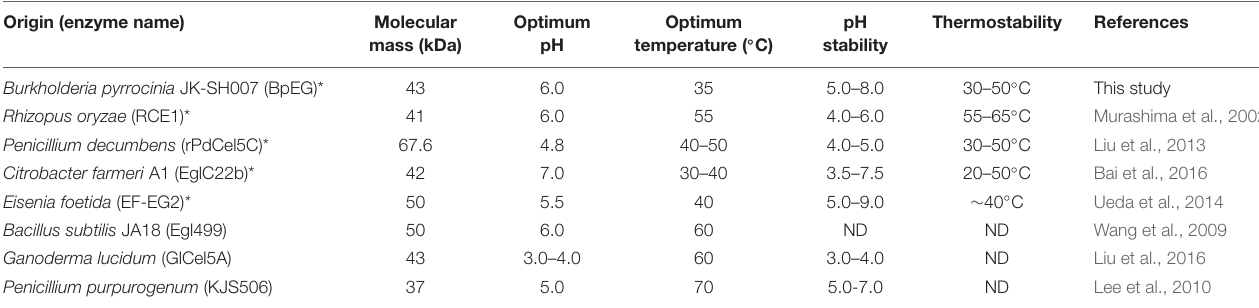
FIGURE 4 | Functional properties of purified recombinant BpEG. (A) Effect of pH on enzyme activity at 35 ◦ C. (B) Effect of pH on enzyme stability at 35 ◦ C. (C) Effect of temperature on enzyme activity measured at 10–60 ◦ C. (D) Effect of temperature on enzyme stability after 15-45 min incubation at 40–90 ◦ C. The bars represent standard deviations. TABLE 2 | Properties of endo-1,4- β -glucanases.